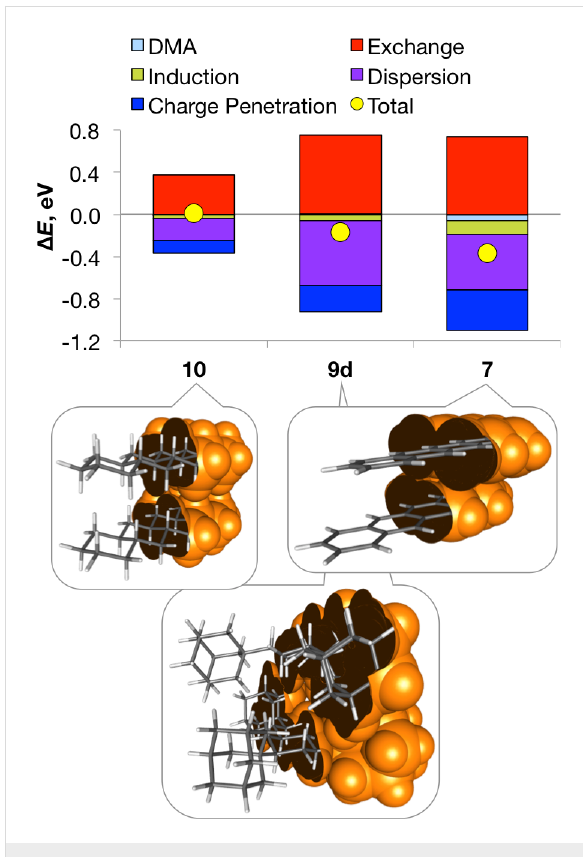
Figure 4: Decomposition of the SAPT0/jun-cc-pVDZ energy difference between the optimized and frozen dimers ( i.e. , ∆ E = E total or component [optimized] – E total or component [frozen]) for the representative cores from classes (II) and (III), as well as the M06-2X/ def2-SVP geometries of their optimized dimers (clipped van der Waals surfaces are shown in